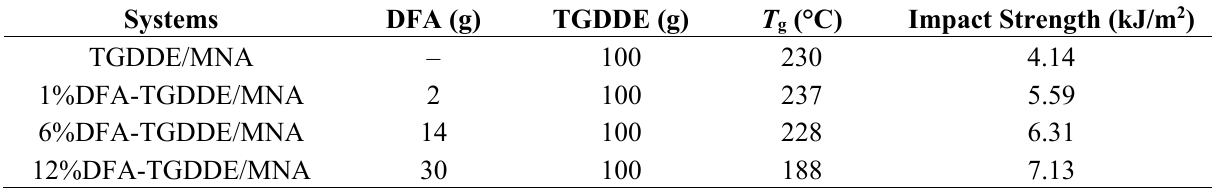
Table 3. The T g and impact strength of the cured resins.